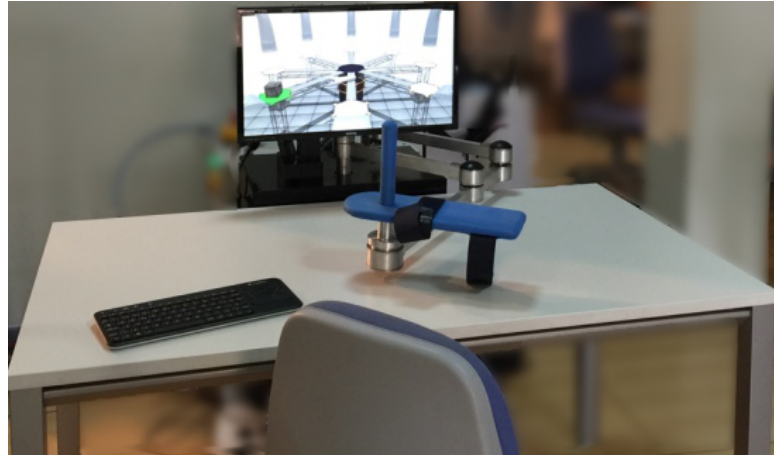
Figure 1. PUPArm